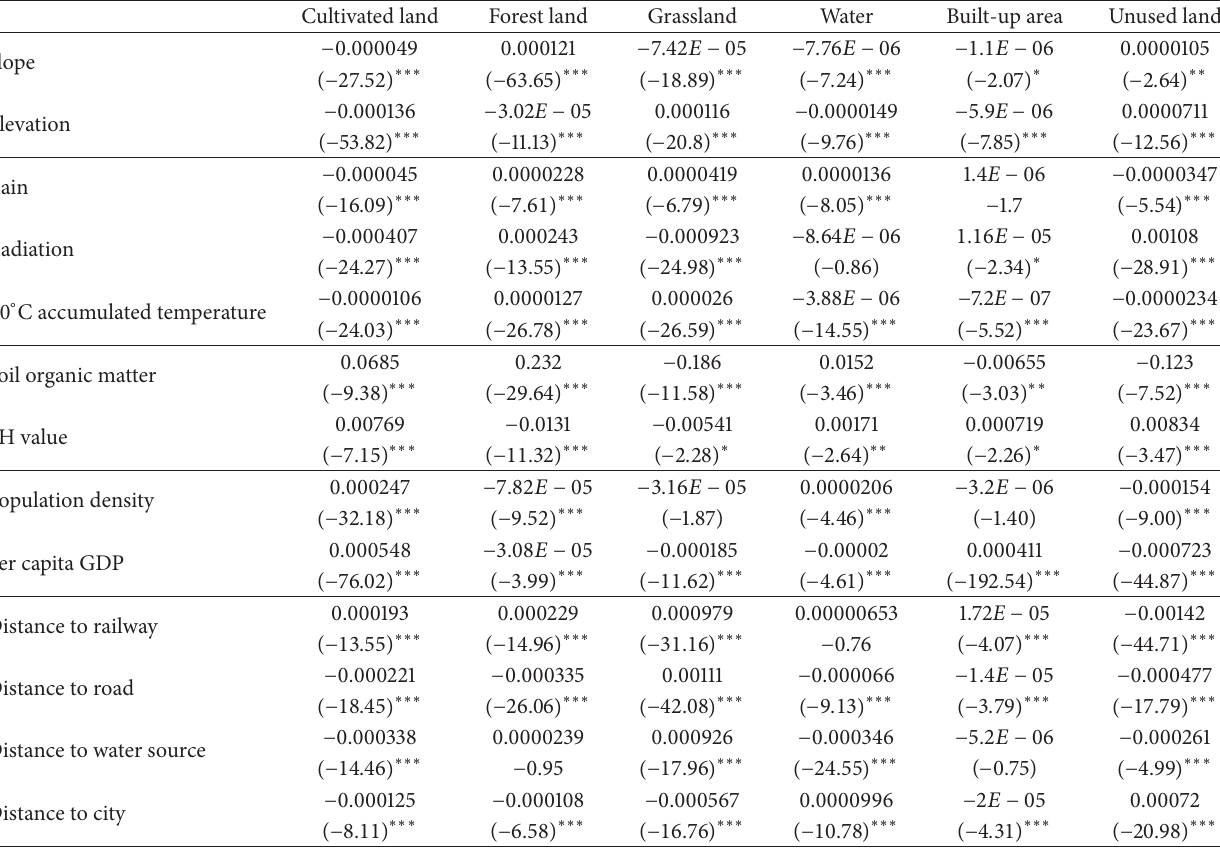
Table 2: Results of logistical regression for the six land use types with 13 driving factors. Cultivated land Forest land